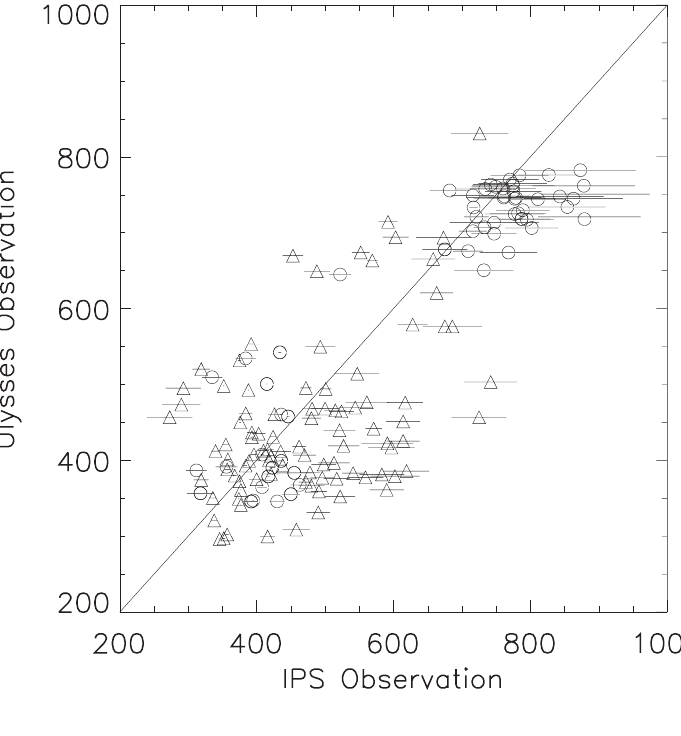
Fig. 4. Correlation between IPS and Ulysses observations. Triangle and cir- cle plots show the data at latitudes lower and higher than 45 ◦ , respectively. Plots which did not converge are not in-